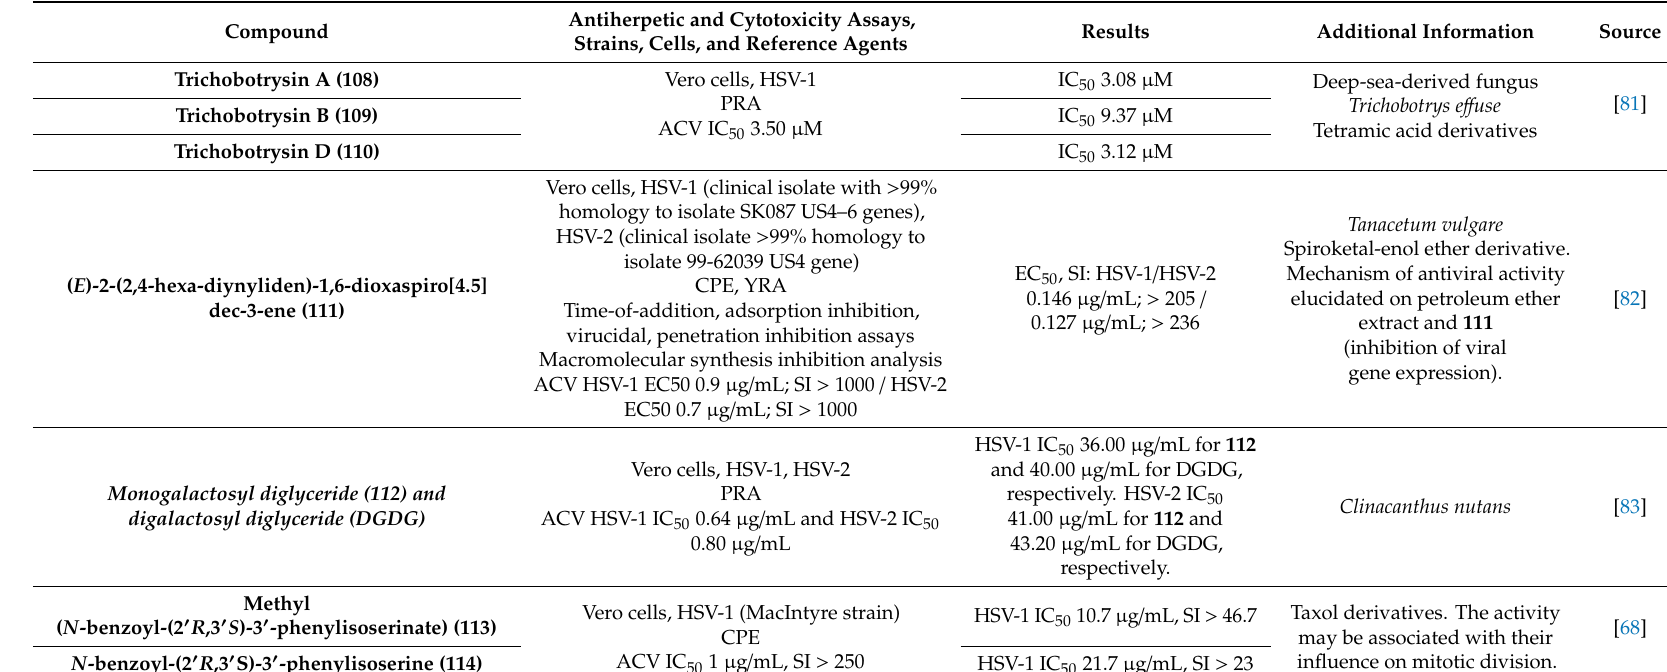
Table 4. The overview of miscellaneous small molecules with anti-HSV